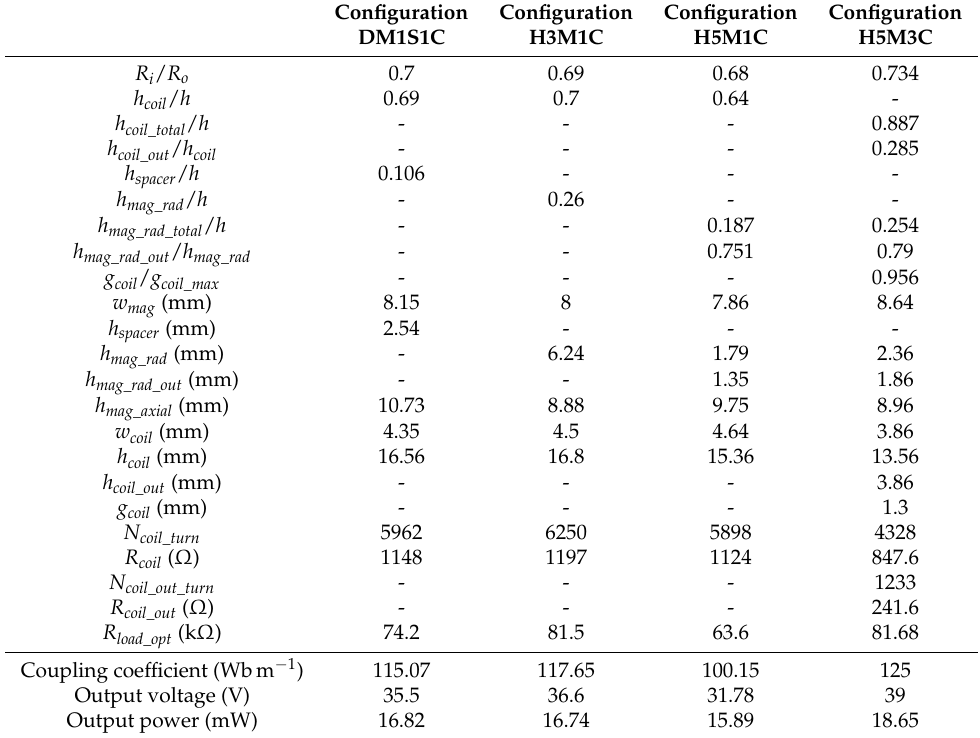
Table 8. Design and performance parameters of the four configurations after optimization for maximum electromagnetic